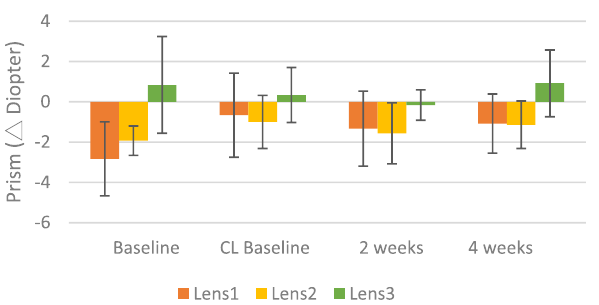
Figure 5. Distance Howell card performance on Measurements × Groups; error bars represent the standard deviation.